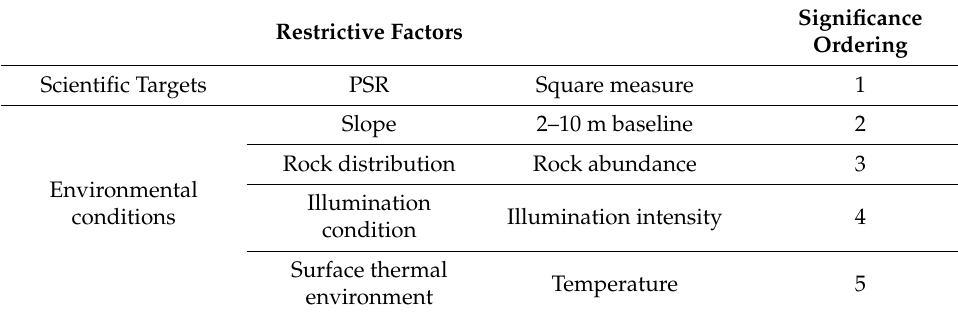
Table 2. The order of significance of the engineering constraints.